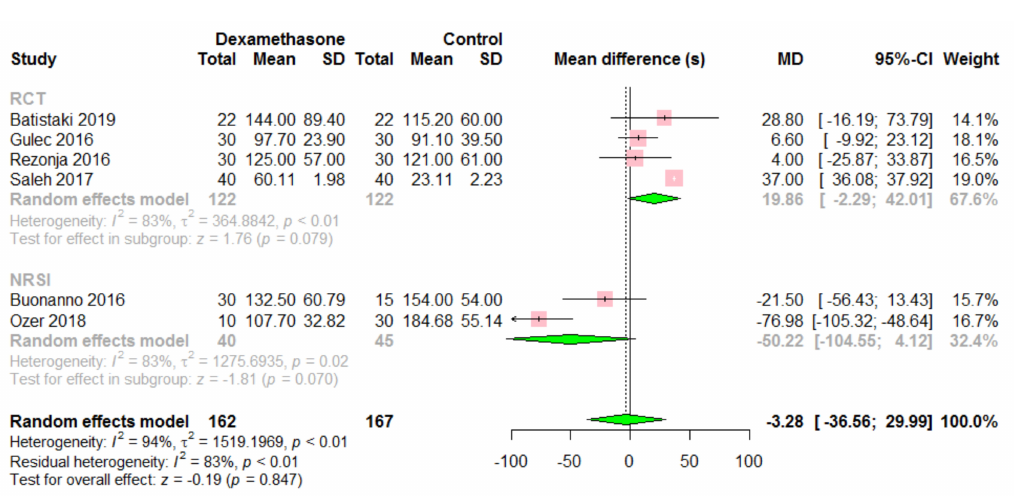
Figure 2. Time(s) to recovery of TOF ratio > 0.9. Dexamethasone vs. control.